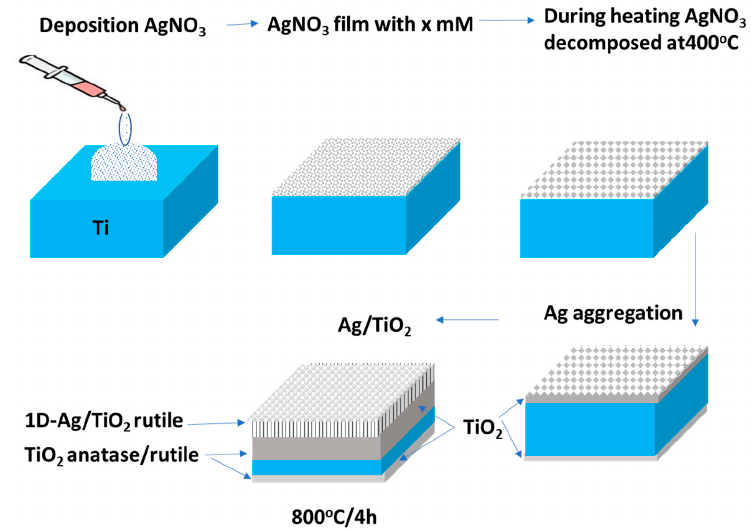
Figure 5. Schematic illustration for the preparation steps and growth mechanism of Ag/TiO 2 nanorods.